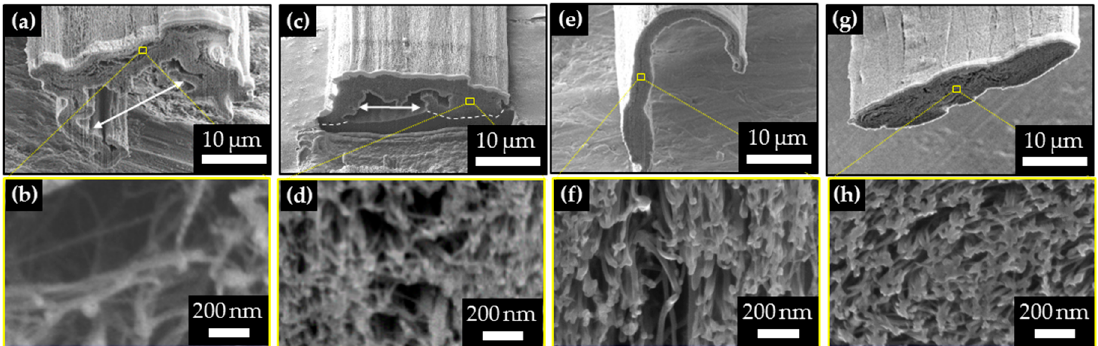
Figure 2. The cross-section of CNTFs: ( a , b ) pristine, ( c , d ) CL160, ( e , f ) pressed , ( g , h ) AAD pressed and cross-linked . Pressing eliminated several micrometer-size voids and AAD injection while pressing aggregated bundles. White arrows in ( a , b ) indicate the micrometer-size voids > 10 μ m.